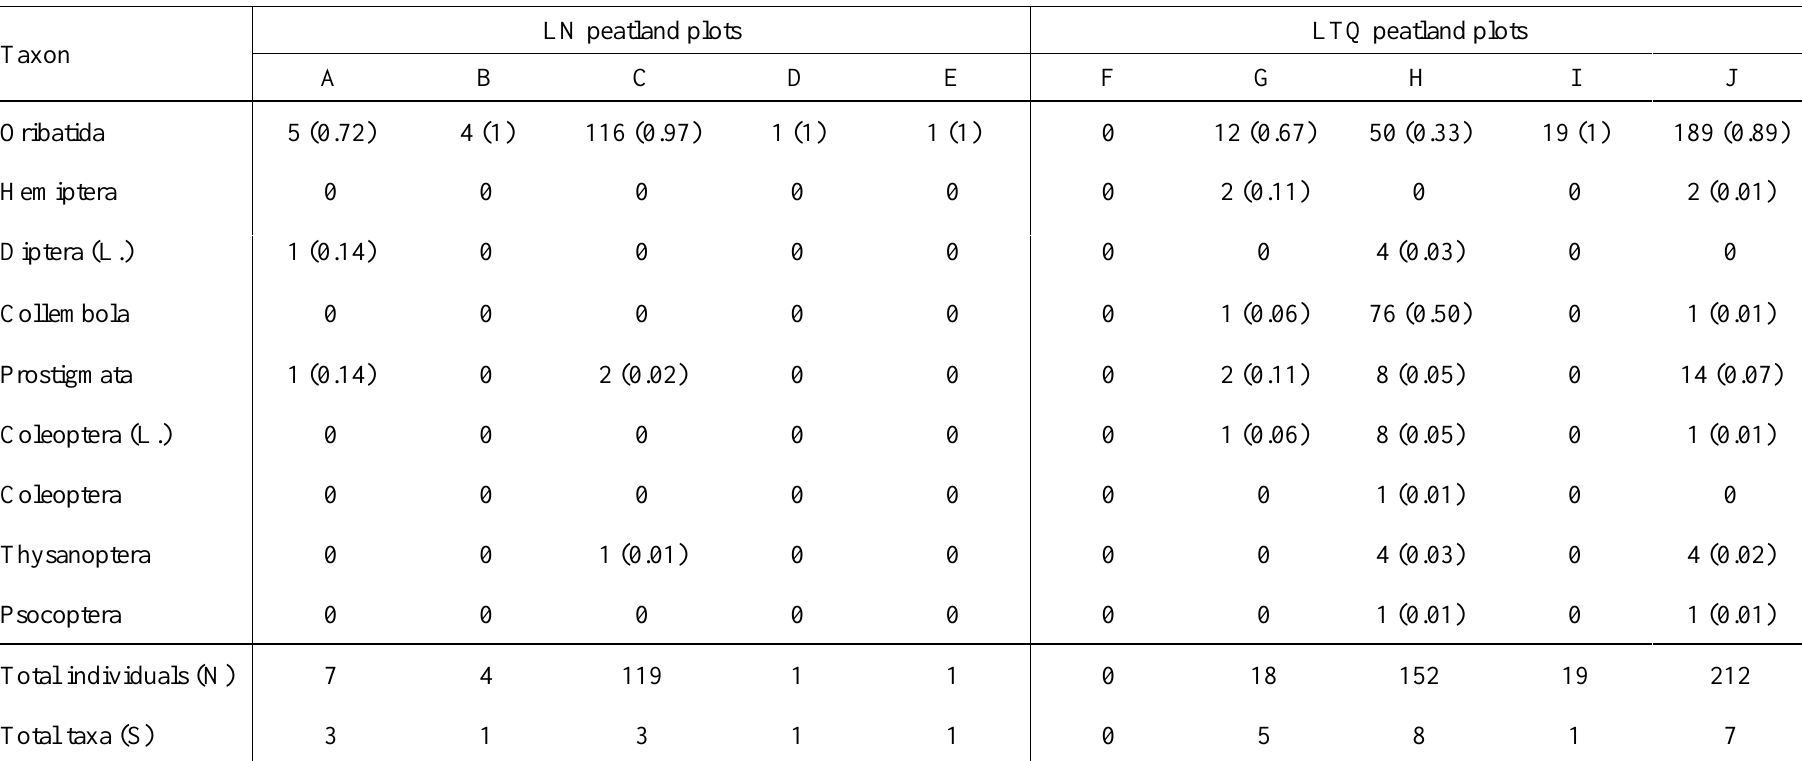
Table 3. Results of the analysis of mesofauna communities: number (and proportion) of individuals belonging to each taxonomic group, total number of individuals (N) and total number of taxonomic groups (S) registered per plot in Laguna Negra (LN) peatland (A–E) and Laguna Tres Quebradas (LTQ) peatland (F–J). L. = larvae.